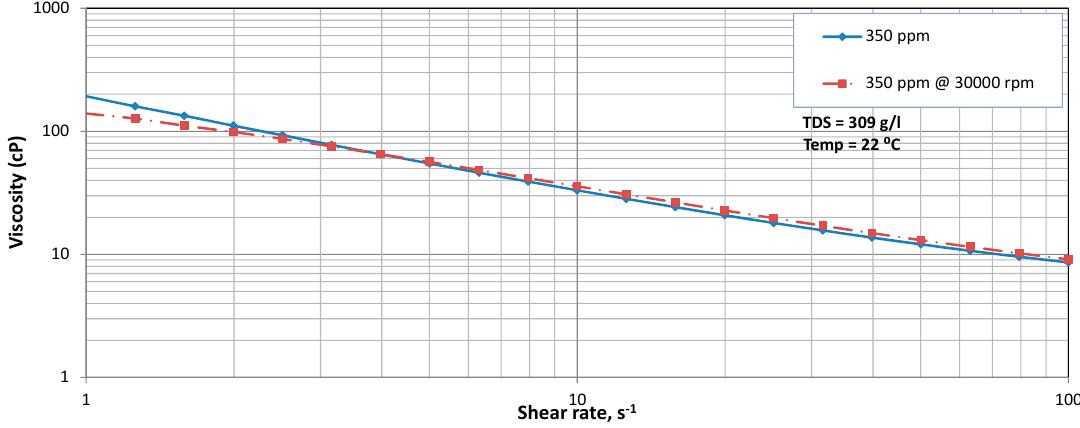
Figure 8. Effect of shearing on biopolymer solution viscosity (extreme conditions). Brine TDS = 309 g/L.